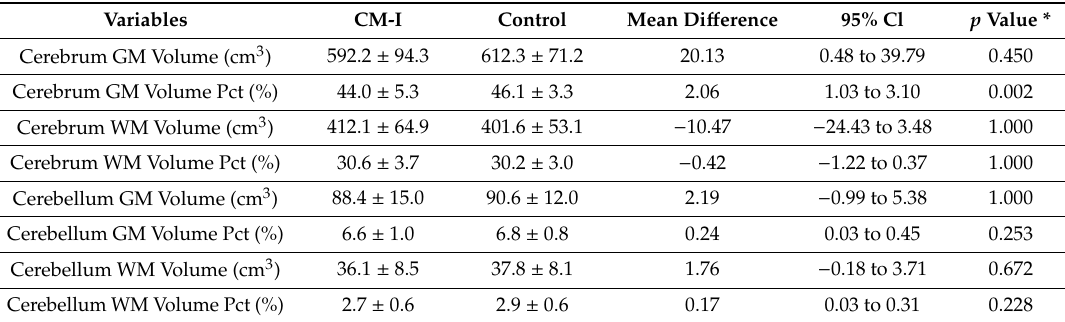
Table 3. Comparison of cerebrum and cerebellum gray / white matter volumes and volume percentages between CM-I and control